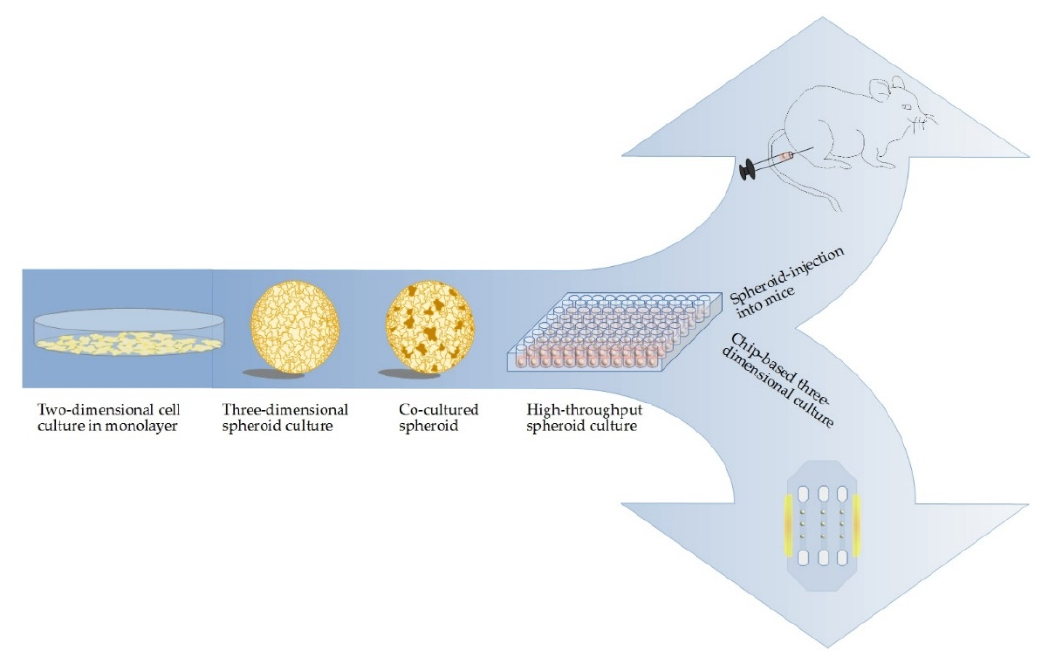
Figure 2. Increment of complexity in cell culture methods for PDAC research: cancer research is moving forward from monolayer cultures towards the use of spheroids. Including a second cell line, e.g., fibroblasts, into the model further increases the complexity. One-step further, spheroids are injected into mice for an advanced model in vivo with the possibility to mimic the progression of small metastases to tumors. On the other hand, using biotechnological state-of-the-art, for example HepaChip ® , allows for measurement of cell reactions directly with